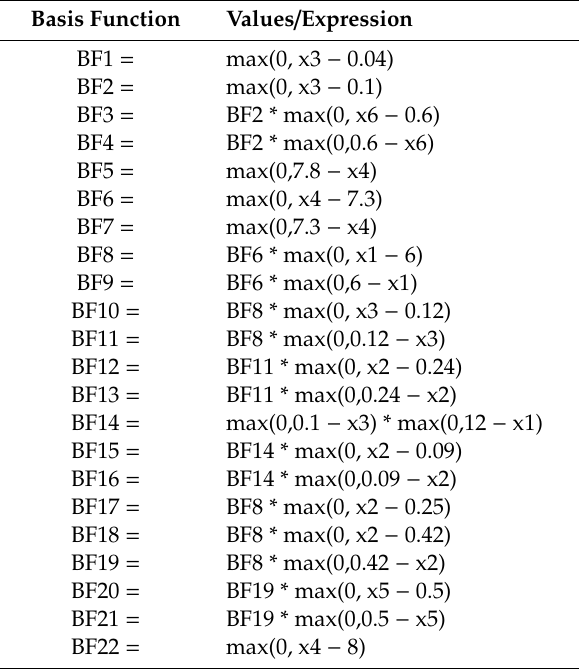
Table 3. Proposed MARS model based on the piecewise-linear